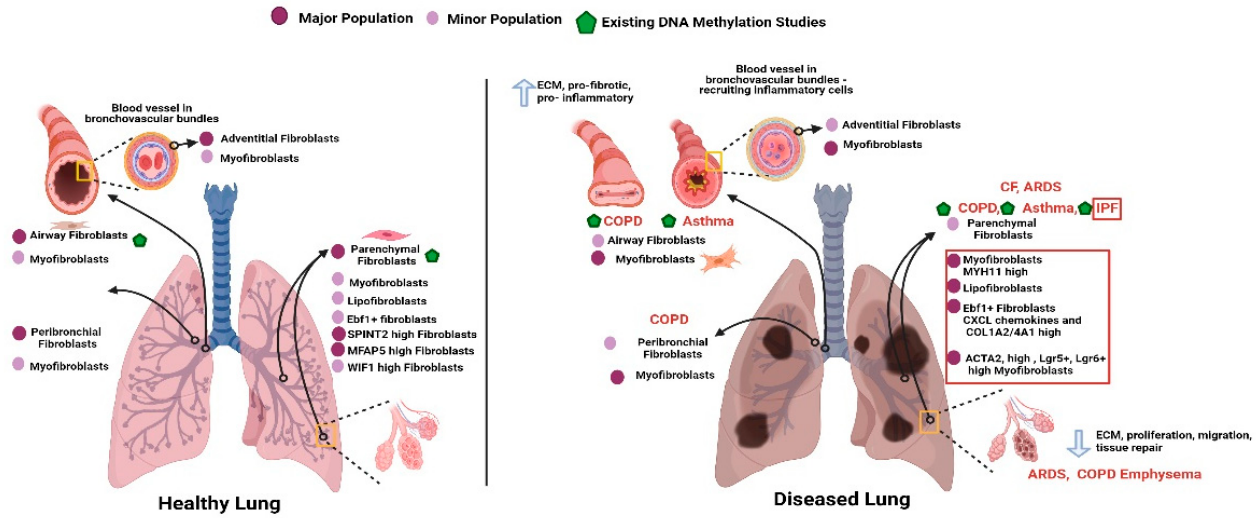
Figure 2. Fibroblast subtypes in healthy and diseased lungs. Diseased lung represents diseases associated with different regions of lung. The major and minor populations of fibroblasts in different pulmonary regions of healthy and diseased lungs are depicted along with indication of existing DNA methylation evidence corresponding to fibroblast subtype and pulmonary fibrotic phenotypes of common lung diseases. Created with BioRender.com, accessed 29 May 2021.